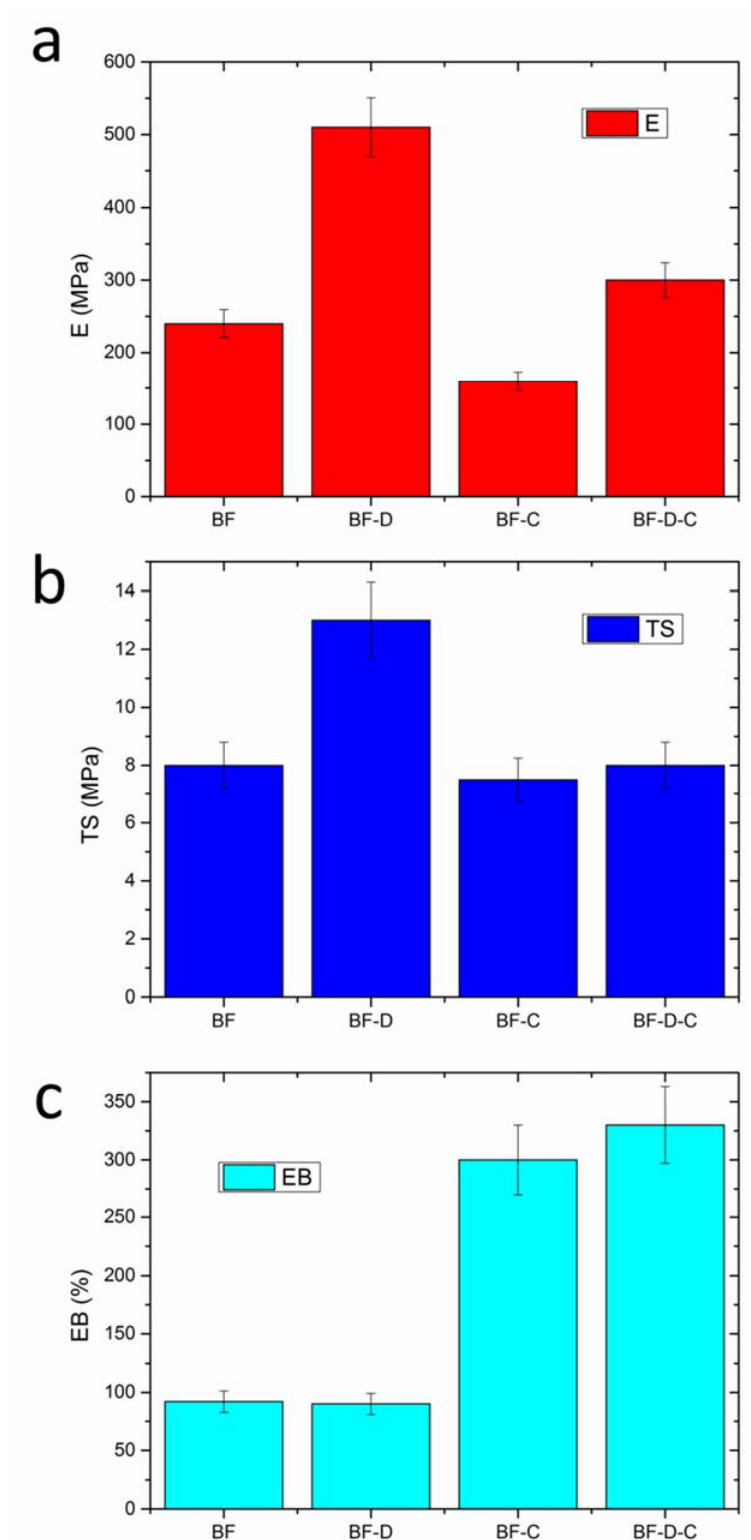
Figure 3. ( a ) Elastic modulus (E), ( b ) tensile strength (TS), and ( c ) elongation at break (EB) of each the four samples investigated.